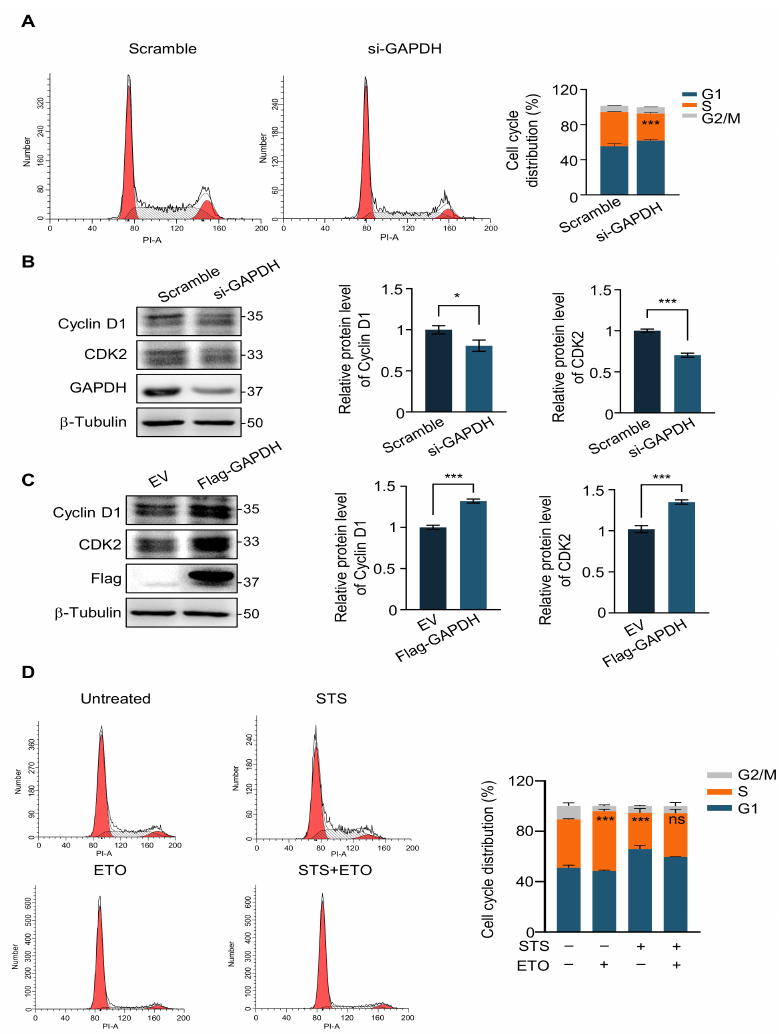
Figure 4. G1 phase arrest diminishes the efficacy of chemotherapeutic agents. ( A ) Cell cycle anal- ysis ( left ) and quantification ( right ) of HeLa cells transfected with scramble siRNA or si-GAPDH. ( B ) Immunoblot ( left ) and quantification ( right ) of indicated proteins in HeLa cells transfected with scrambled siRNA and si-GAPDH for 48 h. ( C ) Immunoblot ( left ) and quantification ( right ) of indi- cated proteins in HeLa cells transfected with an empty vector and Flag-GAPDH for 48 h. ( D ) Cell cycle analysis ( left ) and quantification ( right ) of HeLa cells pre-starved or untreated for 24 h with or without 20 µ M ETO treatment for 2 h. Data represented as mean ± SD of at least three independent experiments. p values are from student’s t -tests. * p < 0.05; *** p < 0.001 and ns: not